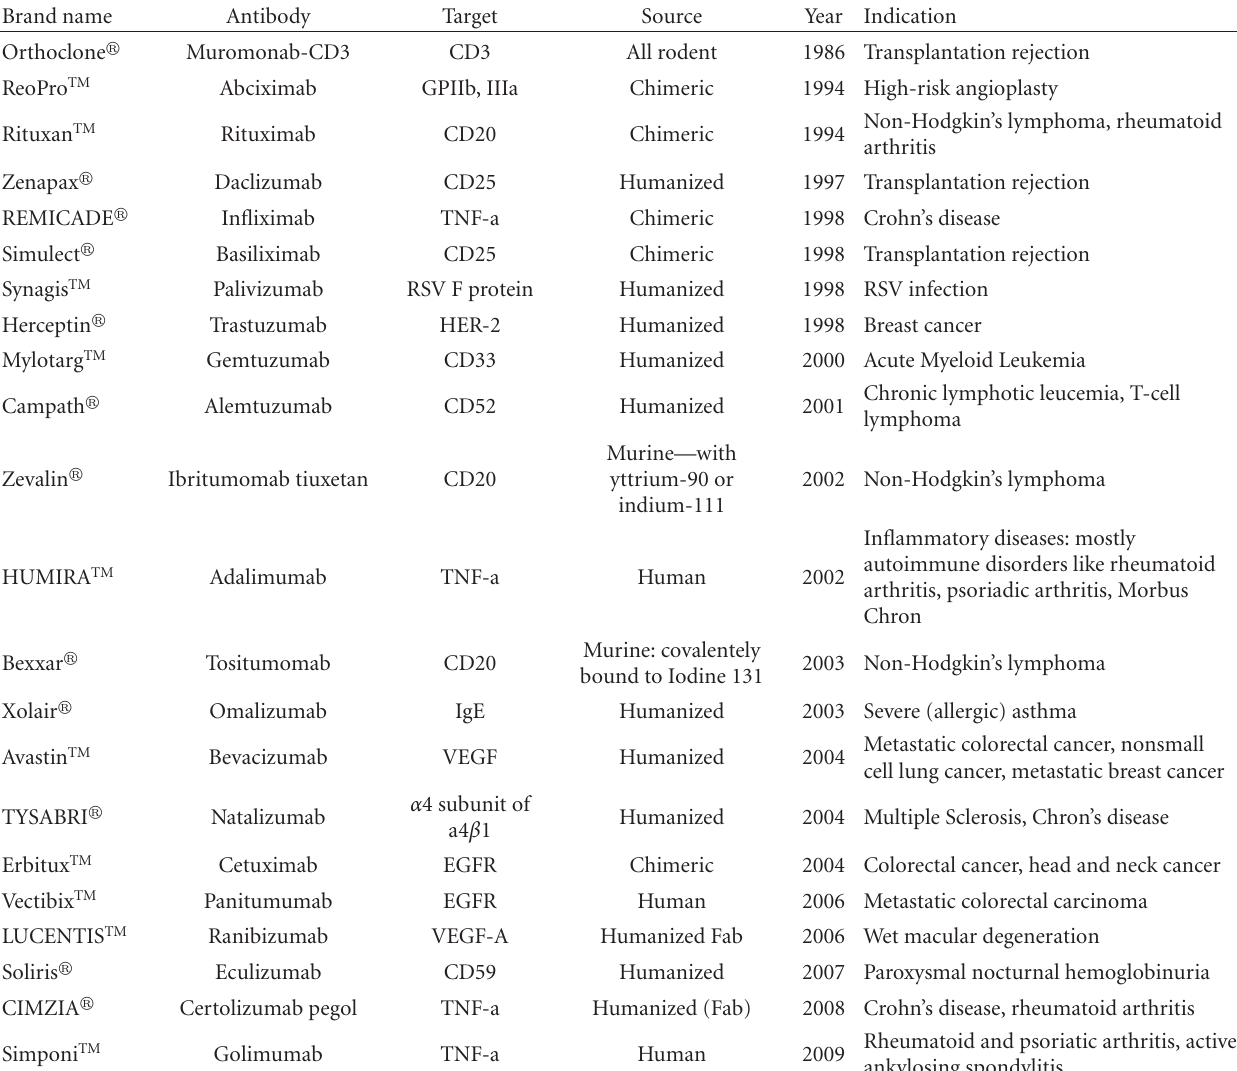
Table 1: FDA-approved therapeutic antibodies